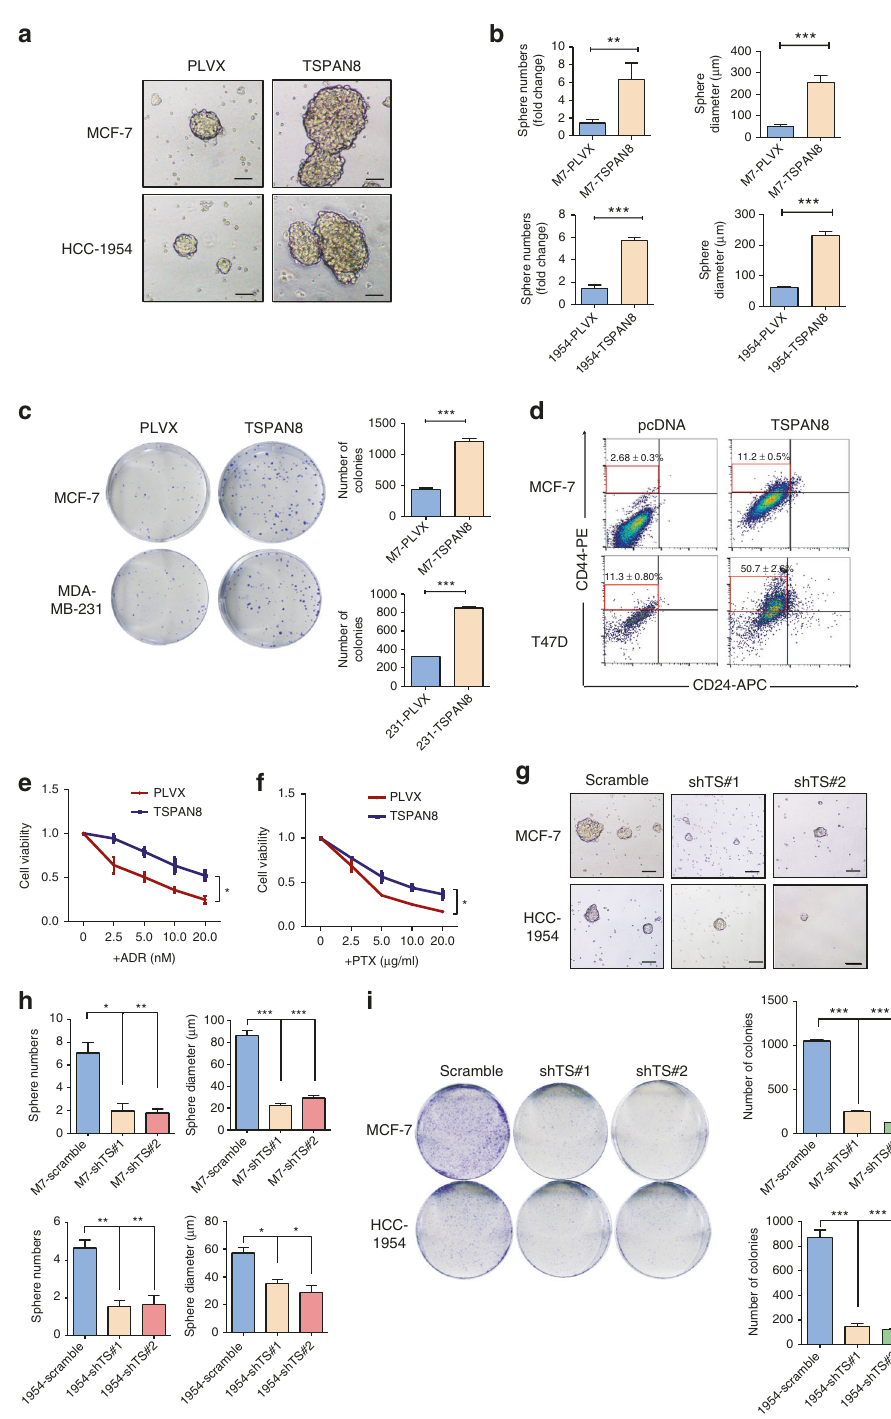
GRK2 inhibitor paroxetine hydrochloride (Fig. 5f) and GSK180736A (Fig. 5g) blocked the TSPAN8-induced SMO phosphorylation, suggesting that TSPAN8 enhances the binding of GRK2 to PTCH1 and SMO, leading to enhanced SMO phos- phorylation. It is worth noting that ATXN3 depletion reduced TSPAN8 overexpression-enhanced MCF7 sphere formation ef fi - ciency (Fig. 5h) and resistance of these cells to chemotherapeutic agents (Fig. 5i). Similarly, depletion of TSPAN8 or ATXN3 in primary cancer cells derived from breast cancer patients decreased these cells sphere formation ef fi ciency and enhanced NATURE COMMUNICATIONS| (2019) 10:2863